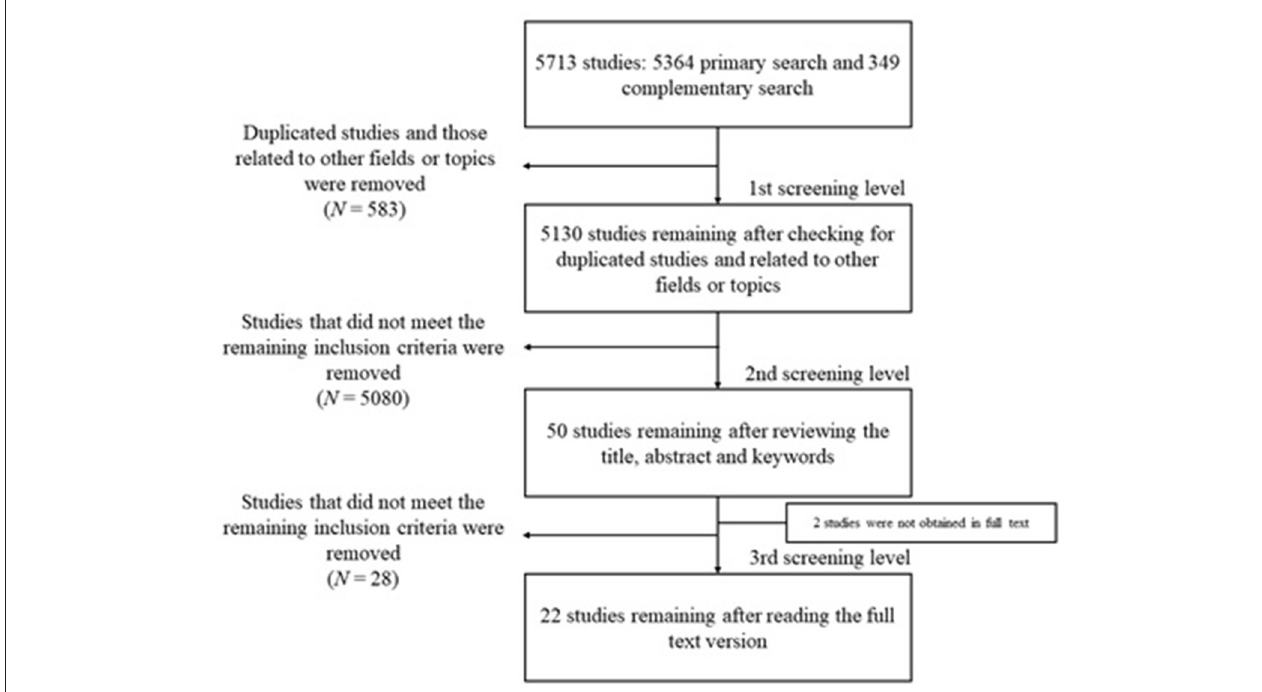
FIGURE 1 | PRISMA flow chart for the literature search and screening (Page et al.,